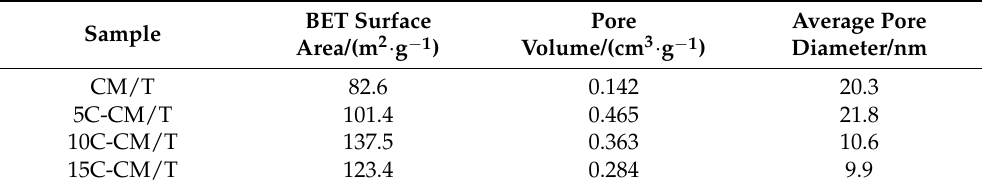
Table 1. Pore structures of the obtained catalysts.